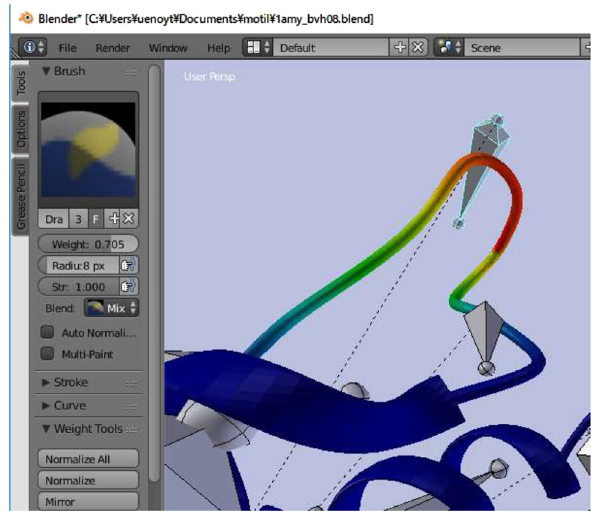
Figure 3: User interface provided by blender to adjust the bone weight for each polygon vertex. For the flexible tube representing a loop region of the peptide chain, vertices are selected and the “ weight paint ” mode allowsbone-weight changesassignedto thosevertices, where the weight value is chosen on the left color panel and painted using a